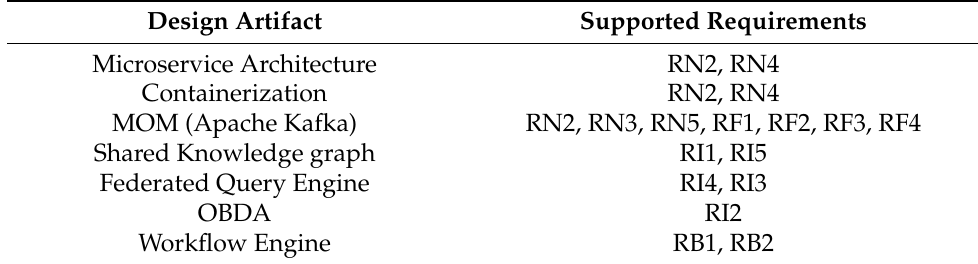
Table 5. Requirements supported by design